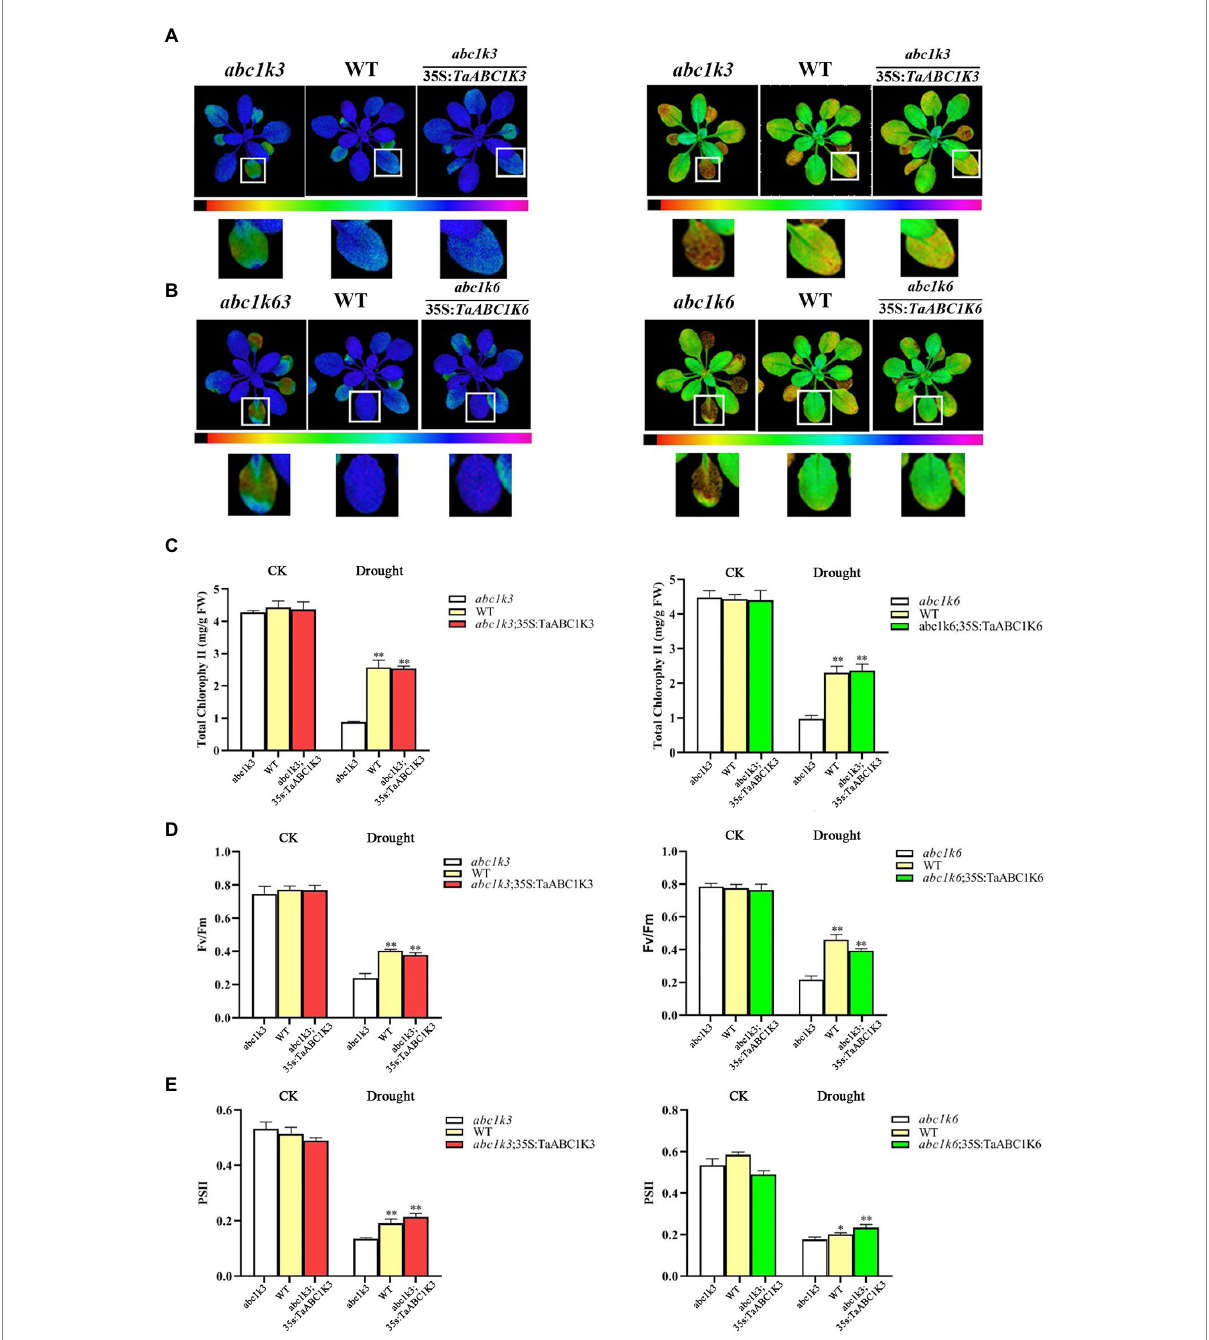
FIGURE 10 Overexpression of TaABC1K3 and TaABC1K6 alleviated the photosynthesis impairment induced by drought stress in Arabidopsis mutant abc1k3 and abc1k6 . (A,B) Chlorophyll fluorescence images showed the efficiency of PSII (FPSII), and the inhibition of PSII quantum yield (lnh) by abc1k3/6 mutant , wild type, and completed complementing experimental plants. (C) Changes in chlorophyll content of mutant, wild-type, and complemented experimental plants after drought stress treatment. (D) Maximum seed yield of each plant ( F v /F m ) of each plant. (E) PSII efficiency value of the plant in chlorophyll fluorescence image. Statistically significant differences between control group and treatment group were calculated by an independent Student’s t -tests: * p < 0.05; ** p <